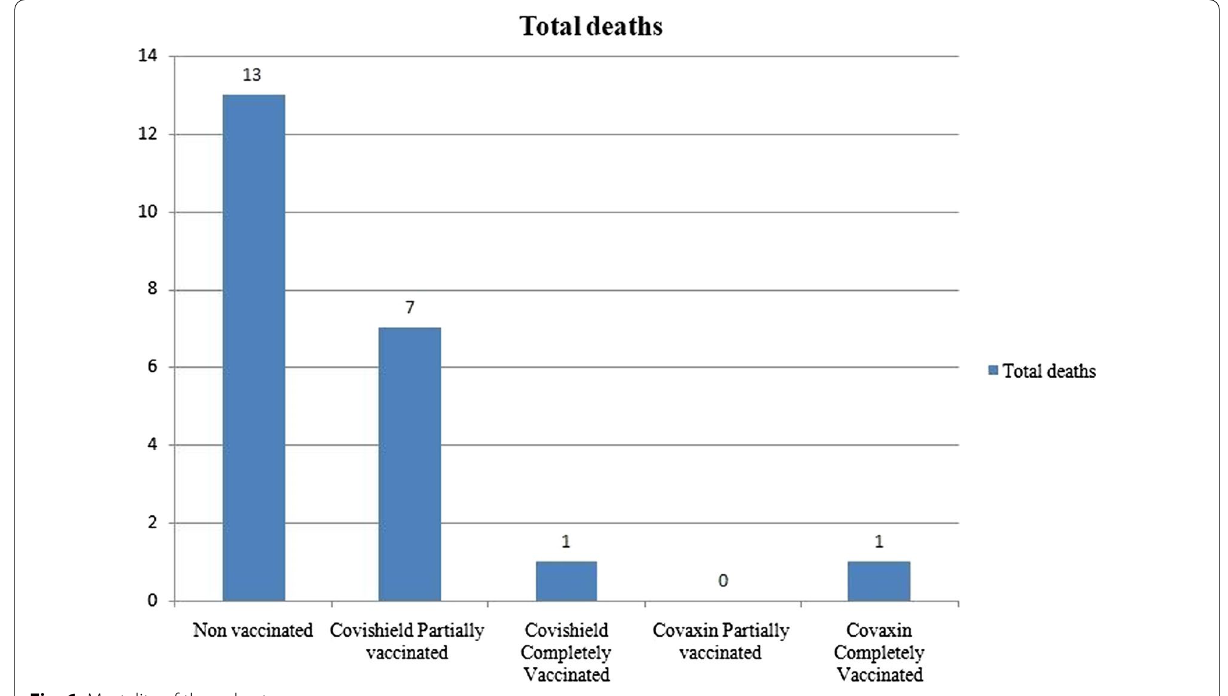
Fig. 6 Mortality of the